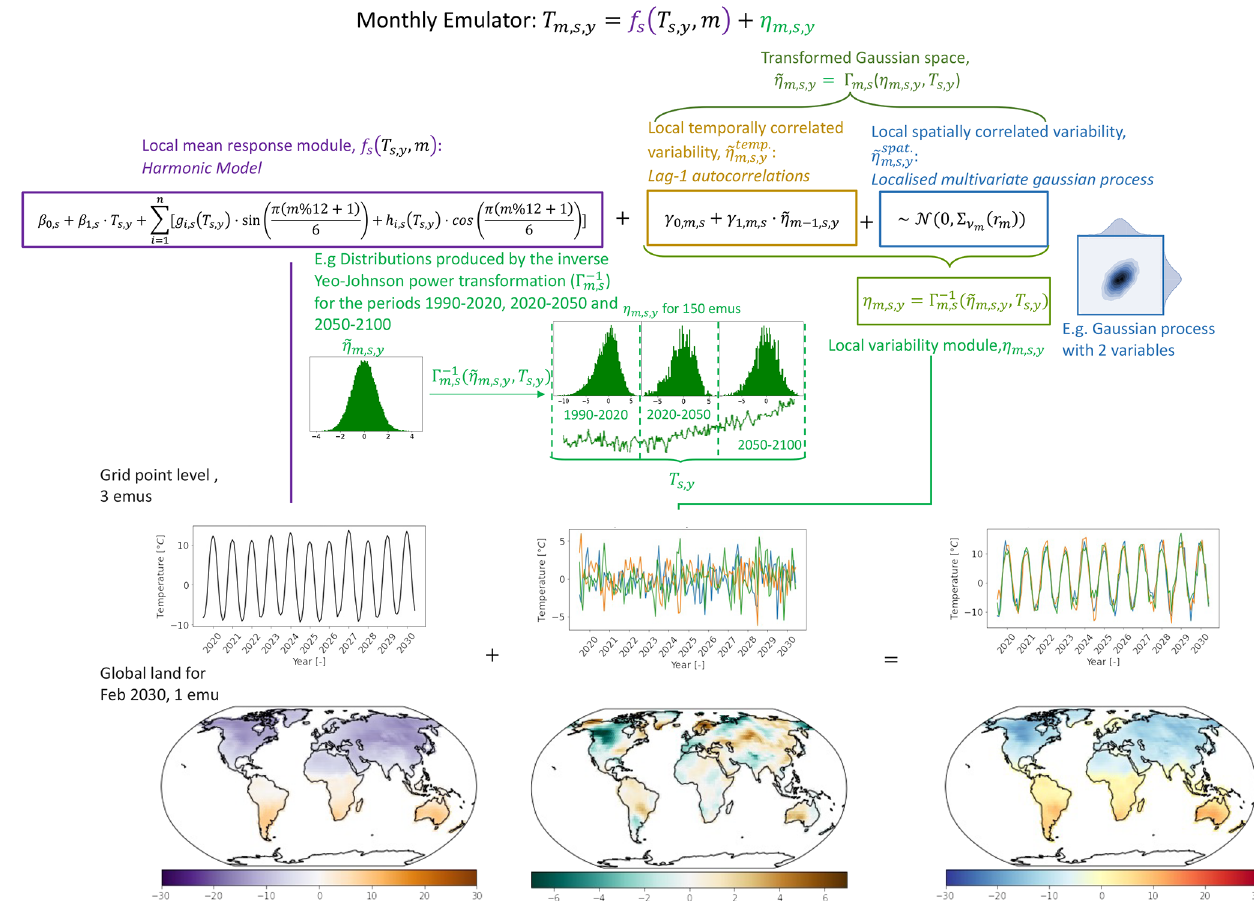
Figure 1. Modular framework for the monthly emulator illustrated for an example ESM. The local mean response module is represented us- ing a harmonic model (Fourier series). The local variability module starts with a Yeo–Johnson transformation before fitting the AR(1) process (distinguished into temporally varying (cid:101) η temp . m,s,y and spatially varying (cid:101) η spat . m,s,y components). An inverse Yeo–Johnson transformation is applied to emulated realizations drawn from the AR(1) process. A schematic illustrating the inverse Yeo–Johnson transformation’s representation of the residual distribution skewness (grouped into the periods 1990–2020, 2020–2050, and 2050–2100) with evolving yearly temperatures (plotted below the distributions) is provided. Example data for the multivariate Gaussian process used within (cid:101) η space m,s,y are also given. Three emulation examples (“emu” in the figure) are shown as time series for one grid point, and one emulation example is also shown as a global